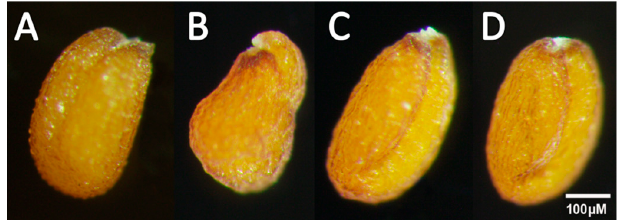
Figure 4. RcWRI1-A and RcWRI1-B complemented the Arabidopsis wrinkled seed phenotype. The seed phenotype was examined by a stereo microscope. ( A ) Wild type; ( B ) wri1-1 mutant; ( C ) wri1-1 expressing RcWRI1-A ; ( D ) wri1-1 expressing RcWRI1-B .